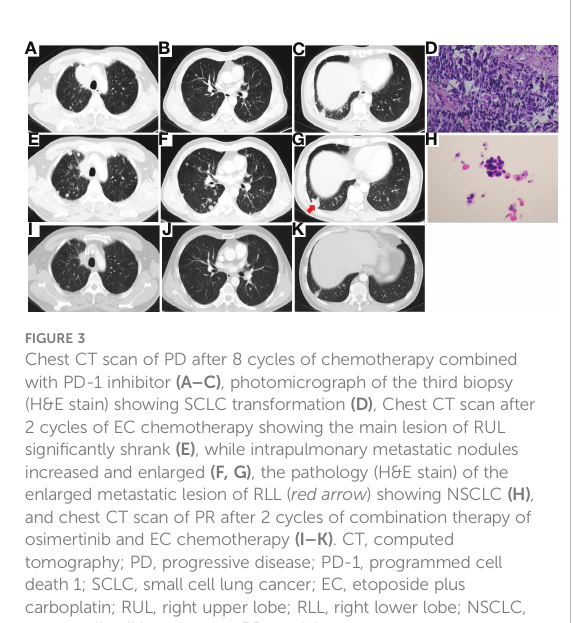
To fi nd out the reasons for the inconsistent response of different lesions to EC chemotherapy, we performed a needle aspiration of an enlarged metastatic lesion in the right lower lobe (RLL). The pathological results revealed NSCLC (Figure 3H) with the genetic testing showing EGFR 19del and T790M (+).